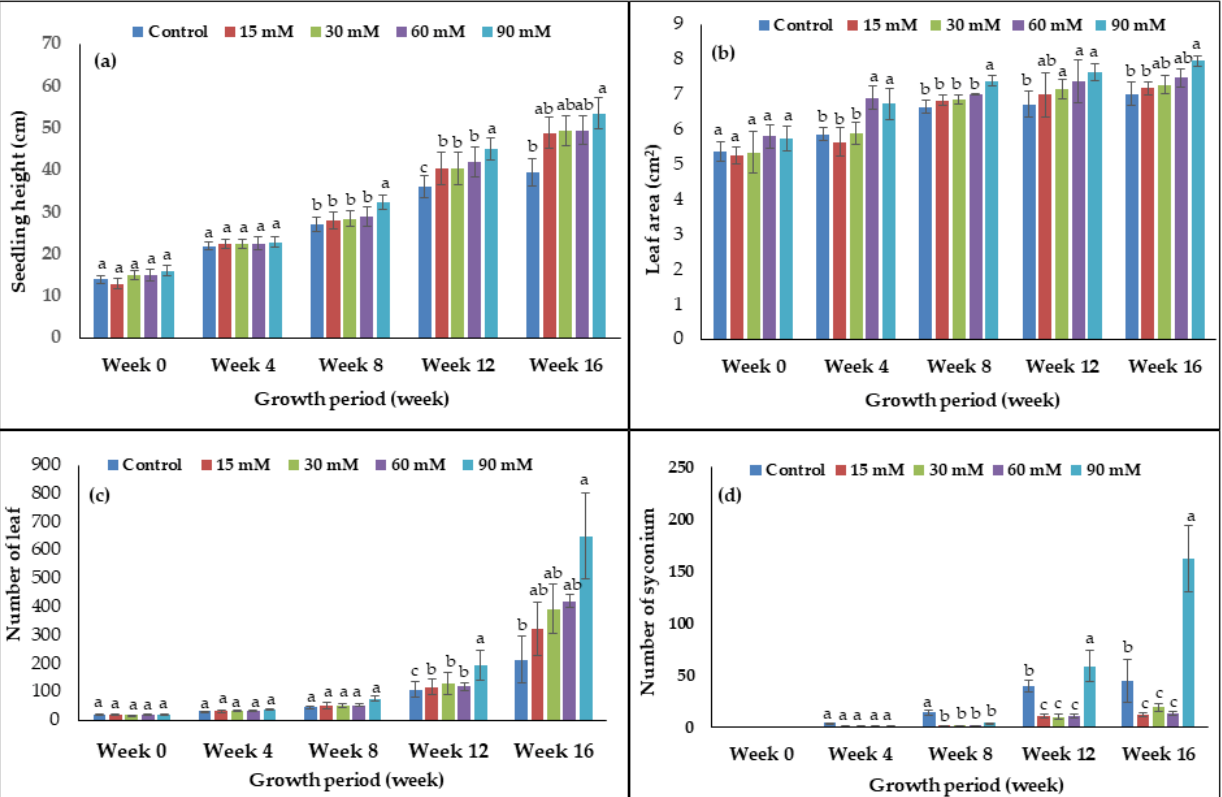
Figure 1. The effects of H 2 O 2 on ( a ) seedling height, ( b ) leaf area of mature leaves, ( c ) number of leaf, and ( d ) number of syconium of F. deltoidea plants. Bars represent means ( n = 7) ± standard error (S.E.). a, b, and c indicate significant differences within each growth period ( p < 0.05, Tukey’s Honestly Significant Difference (HSD) ‐ test)).